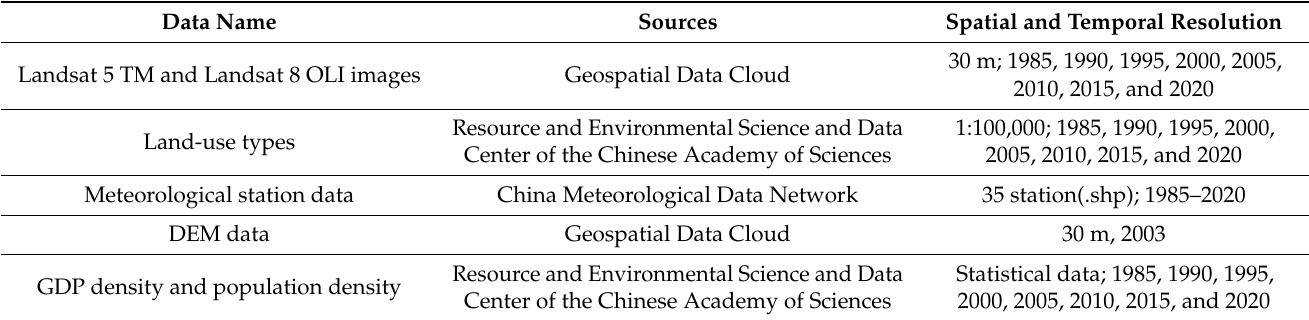
Table 1. Data description and sources.